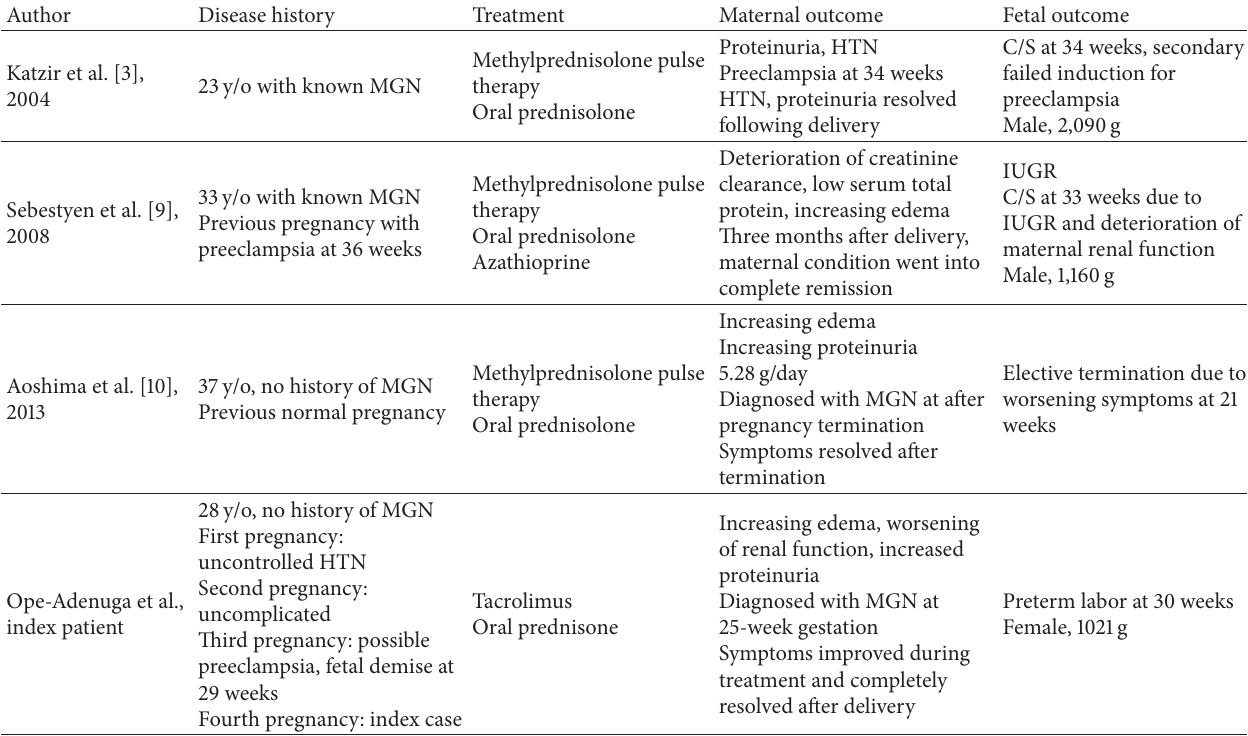
Table 2: Case reports of membranous glomerulonephritis in